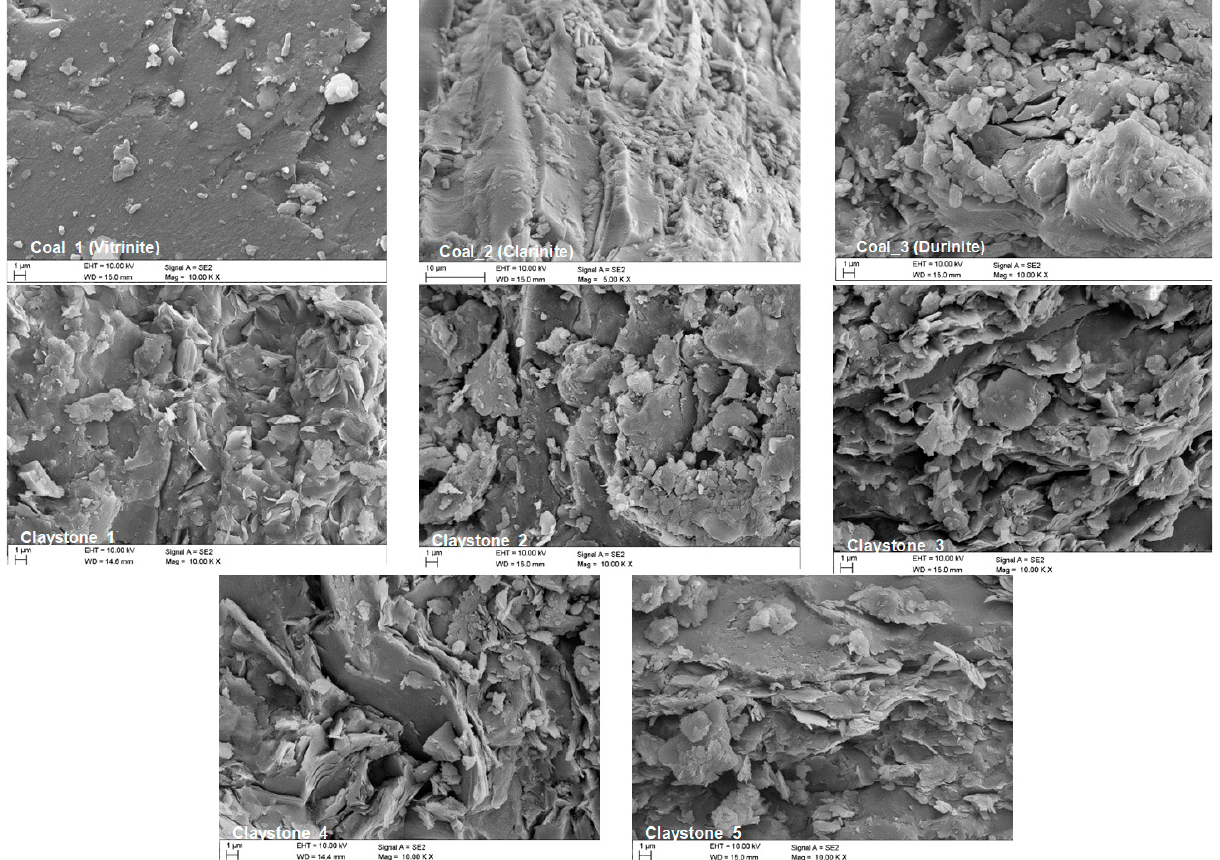
Figure 4. Example of micrographs of claystones and coals, SEM. Table 2. Results of the chemical composition analysis of the coals and claystones studied.